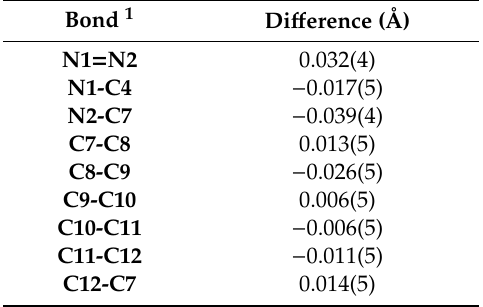
Table 2. Bond length di ff erences between Na5 and azobenzene (Na5–azobenzene).